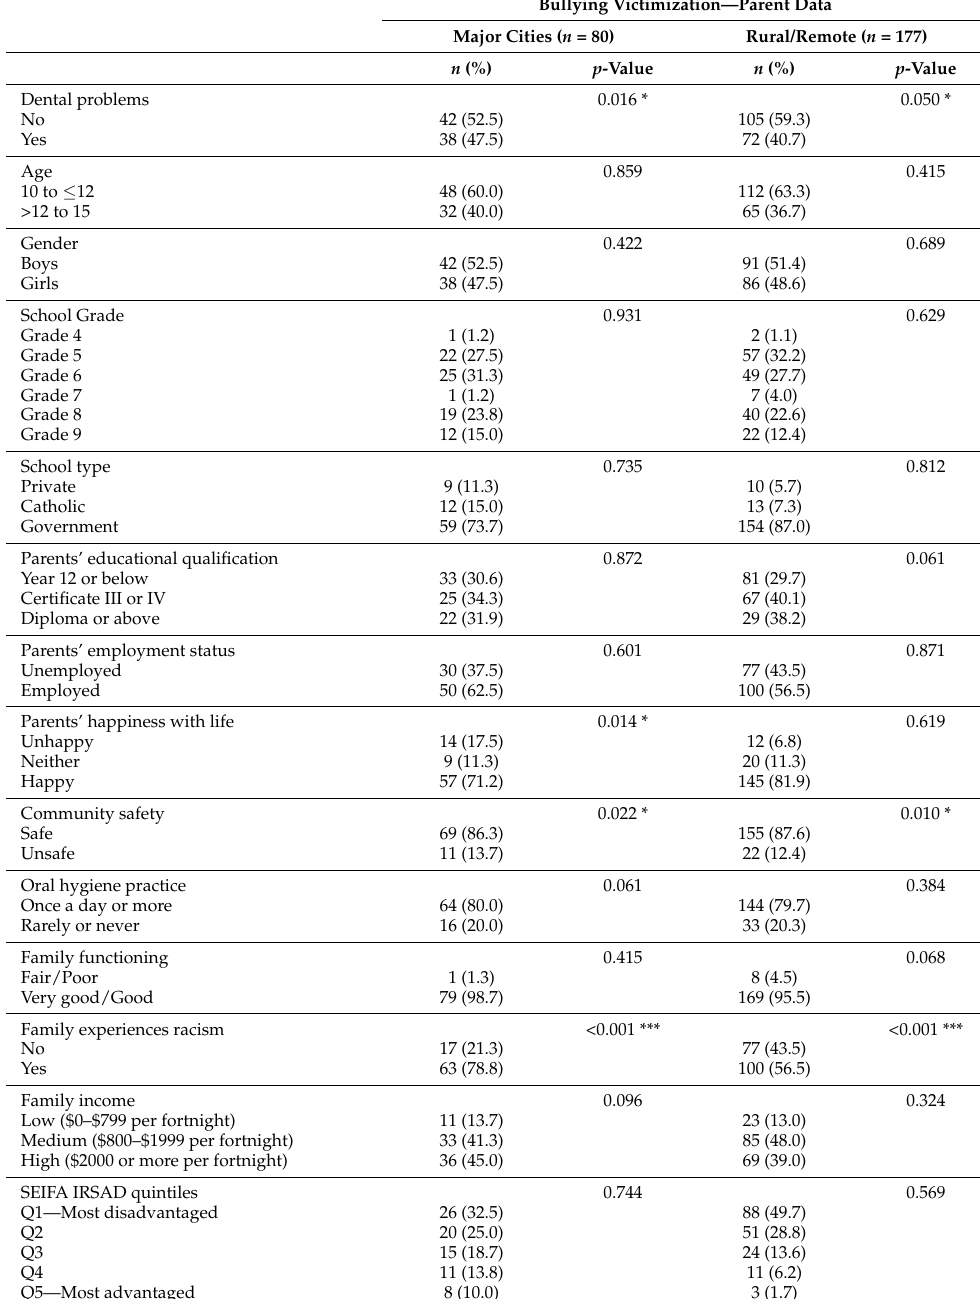
Table 3. Bivariate associations between explanatory variables and bullying victimization by remoteness—Parent